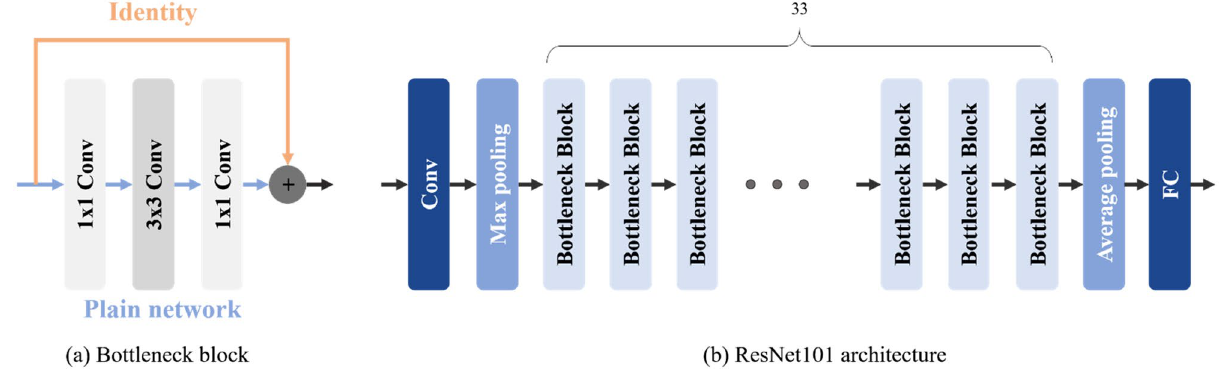
Figure 2. The layer structure of bottleneck block and ResNet101. ( a ) Bottleneck block has a skip connection by adding identity to plain network. ( b ) ResNet101 consists of 33 bottleneck